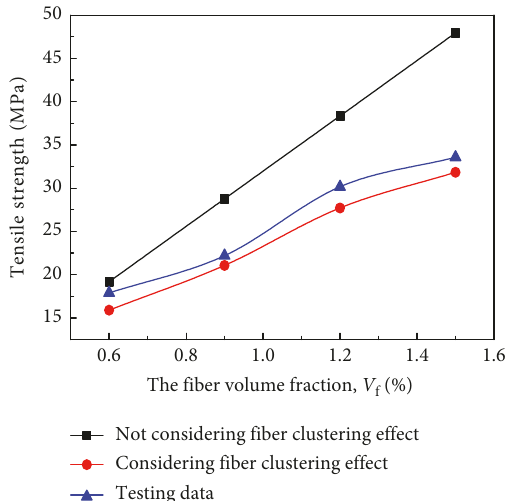
Figure 10: Calculated and experimental values of the tensile strength of the BF/EP composite material as a function of fiber volume fraction